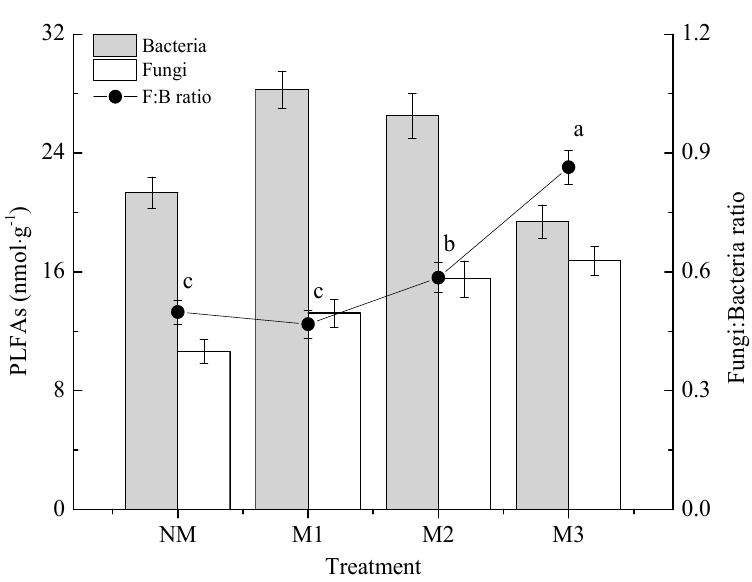
Figure 3. Bacteria, fungi and the fungi:bacteria (F:B) ratio in P. edulis stands of different mulching years. The bars are the means ± standard error ( n = 9). Different lowercase letters in the figure indicate significant differences among different treatments at the p < 0.05 level. NM, M1, M2 and M3 represent no-mulching, mulching for one year, two years and three years, respectively.